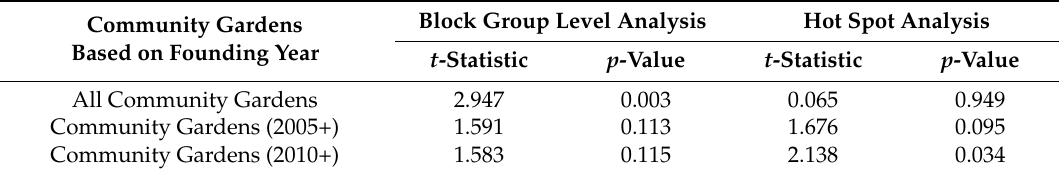
Table 2. t -tests of change in per capita income (2010–2015) for block group level and hot spot analyses. The block group level analysis represents lower-income census block groups with access to one or more community gardens vs. lower-income block groups with no gardens within 1 analysis represents lower-income census block groups inside hot spots vs. those outside hot spots. Both analyses were performed multiple times based on the year the gardens were founded (all, 2005+, and 2010+) and excluded block groups with coefficients of variation larger than